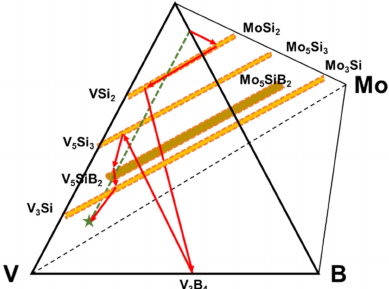
Figure 6. Illustration of the di ff usion pathway on the V-9Si-5B substrate based upon the coating structure in Figure